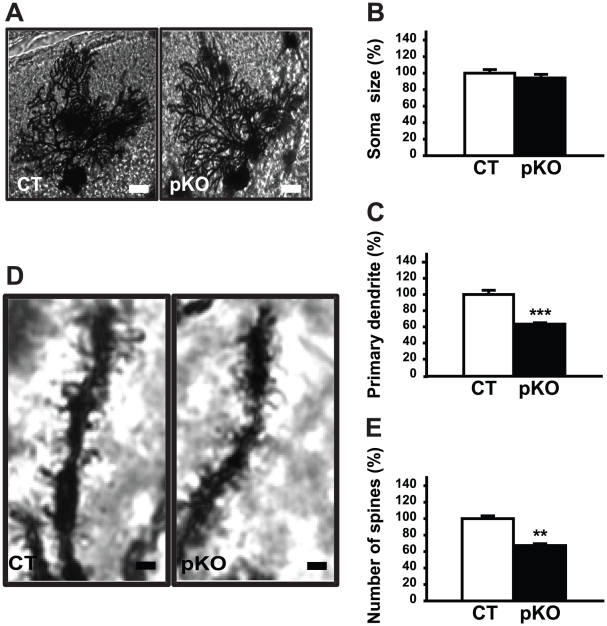
Purkinje cells in Dyt1 pKO mice.(A) A representative Purkinje cell from control and Dyt1 pKO mice, produced at 40× magnification. (B) The size of the Purkinje cell soma in Dyt1 pKO mice was not significantly different than those of CT mice. (C) The large primary dendrite of the Purkinje cells in the Dyt1 pKO mice was significantly shorter than those in CT mice. (D) A representative quaternary dendrite branch of CT and Dyt1 pKO mice was examined at 100× magnification. (E) The number of spines on the quaternary dendrite branch in the Dyt1 pKO mice were significantly reduced compared to those of CT mice. Scale bars in Panel A represent 10 µm. Scale bars in Panel D represent 1 µm. Bars in Panels B, C and E represent means with standard errors. ** p<0.01, *** p<0.001.